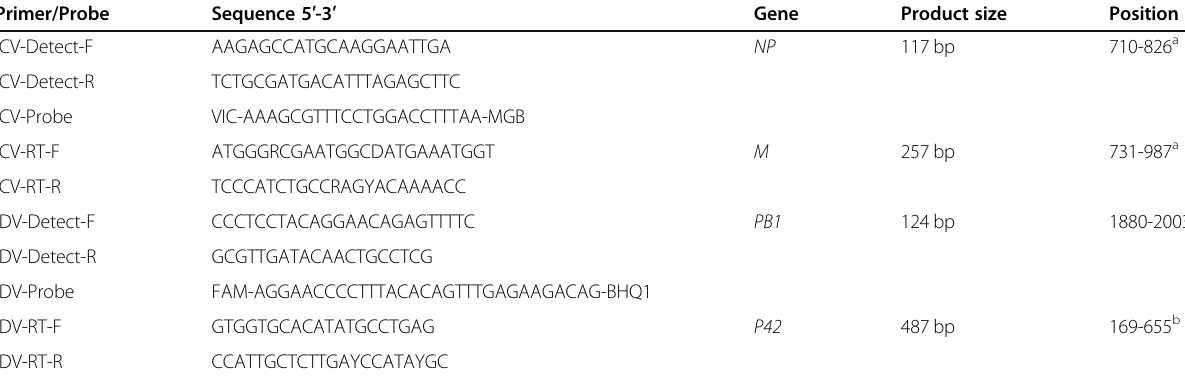
Table 5 Primer and probe sequences for ICV and IDV